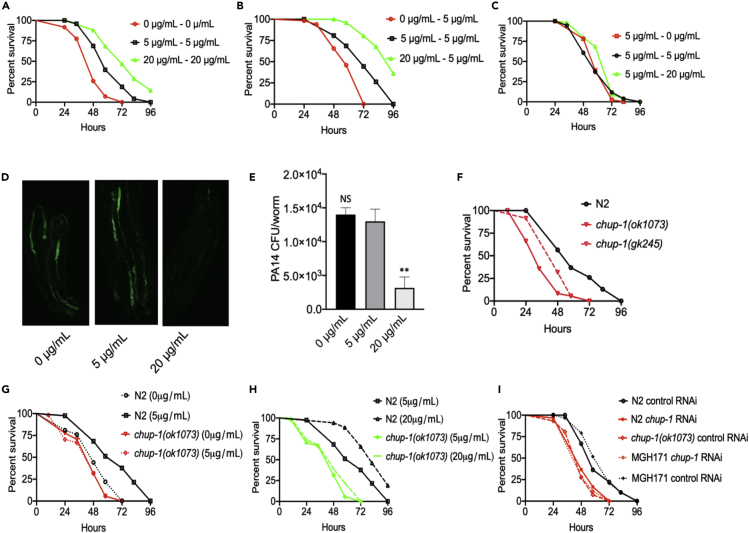
Cholesterol Is Required for C. elegans Resistance against P. aeruginosa(A) Wild-type animals were grown in the absence of cholesterol supplementation (0 μg/mL) or at different cholesterol concentrations, exposed to P. aeruginosa cultured on the same cholesterol concentrations, and scored for survival. WT animals grown on 5 μg/mL cholesterol (control) versus 0 μg/mL, P < 0.0001; 20 μg/mL, P < 0.0001.(B) WT animals were grown on different cholesterol concentrations, exposed to P. aeruginosa cultured at the control cholesterol concentration (5 μg/mL) and scored for survival. WT animals grown on 5 μg/mL cholesterol (control) versus 0 μg/mL, P < 0.0001; 20 μg/mL, P < 0.0001.(C) WT animals were grown on control cholesterol concentration (5 μg/mL), exposed to P. aeruginosa cultured on different cholesterol concentrations (0, 5 and 20 μg/mL) and scored for survival. WT animals grown on 5 μg/mL cholesterol (control) versus 0 μg/mL, P = NS; 20 μg/mL, P = NS.(D) WT animal colonization by P. aeruginosa-GFP after 24 h at 25°C.(E) Colony-forming units per animal grown on P. aeruginosa -GFP after 24 h at 25°C. Bars represent means, whereas error bars indicate SD; ∗∗p < 0.05, NS = not significant.(F) chup-1(ok1073) mutants were grown on 5 μg/mL cholesterol (control), exposed to P. aeruginosa, and scored for survival. WT animals versus chup-1(ok1073) and chup-1(gk245), P < 0.0001.(G) chup-1(ok1073) mutants were grown on 0 and 5 μg/mL cholesterol, exposed to P. aeruginosa, and scored for survival. WT animals grown on 5 μg/mL cholesterol (control) versus 0 μg/mL, P < 0.0001; chup-1(ok1073), P < 0.0001.(H) chup-1(ok1073) mutants were grown on 20 and 5 μg/mL cholesterol, exposed to P. aeruginosa, and scored for survival. WT animals grown on 5 μg/mL cholesterol (control) versus 20 μg/mL, P < 0.0001; chup-1(ok1073) 20 μg/mL, P < 0.0001; chup-1(ok1073) 5 μg/mL, P < 0.0001.(I) Control, MGH171(chup-1 RNAi), WT (chup-1 RNAi) animals were grown on 5 μg/mL cholesterol, exposed to P. aeruginosa, and scored for survival. WT on control RNAi versus chup-1(ok1073) control RNAi, P < 0.0001; WT chup-1 RNAi, P < 0.0001; MGH171 chup-1 RNAi, P < 0.0001; MGH171 control RNAi, P = NS.